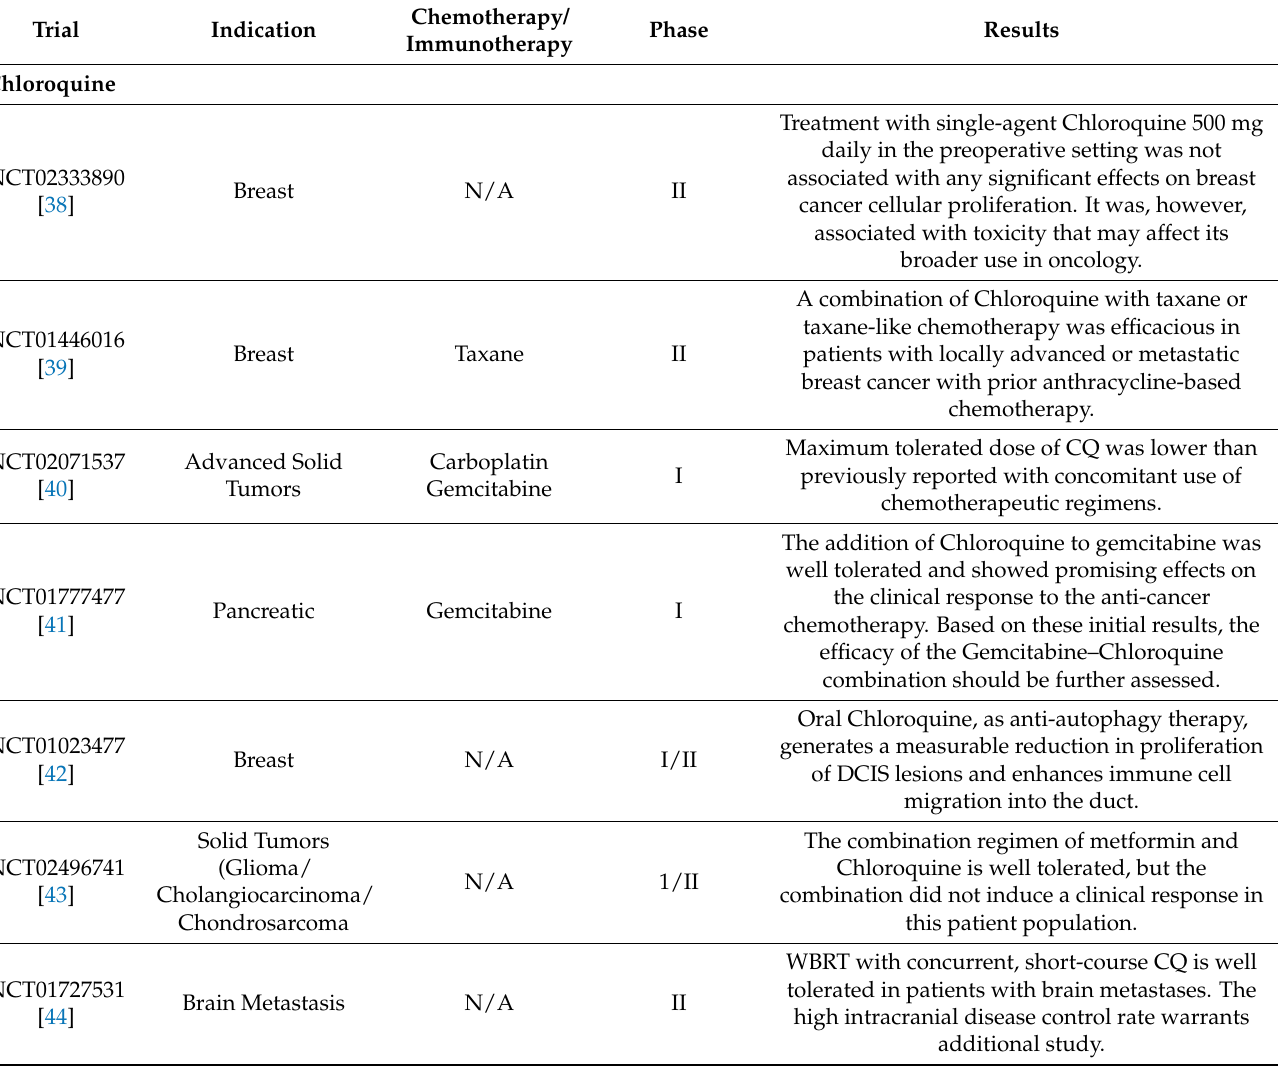
Table 2. Clinical Trials for Chloroquine, Hydroxychloroquine, and Pevonedistat with results. Included are chemotherapy and/or immunotherapy included in